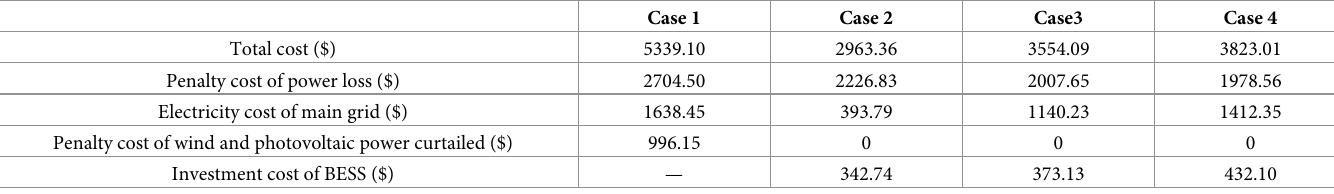
Table 3. Comparison of total costs in different cases.